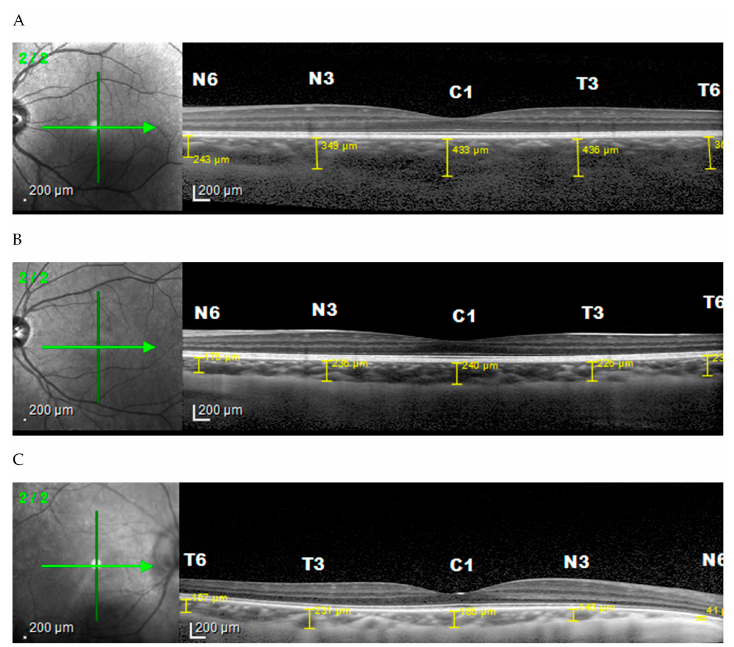
Figure 3. Choroidal thickness based on axial length horizontally. ( A ) Normal axis, ( B ) medium axis, ( C ) long axis.